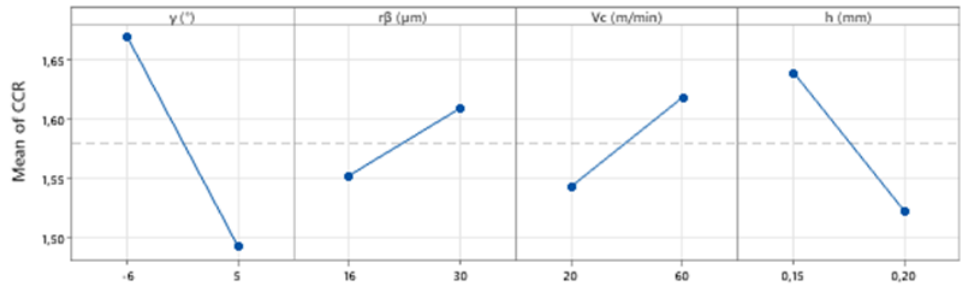
Figure 9. Influence of the cutting parameters on the CCR based on all cutting conditions.